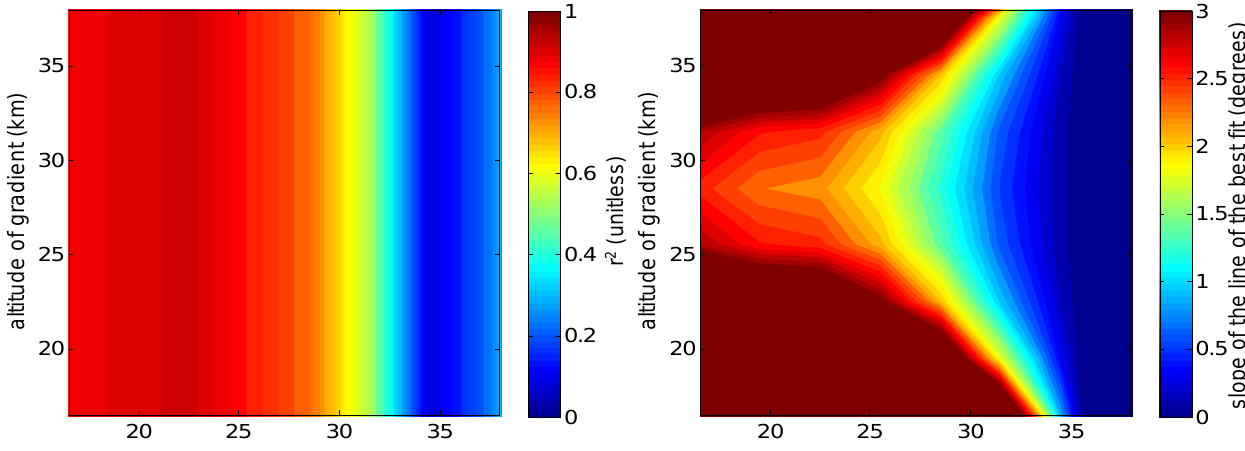
Fig. 12. Same as Fig. 9 but for the simulated linear gradient in Fig. 11. The differences are calculated between the 1-D retrieval and the true (simulated) data, the gradient is obtained from the true (simulated) data.